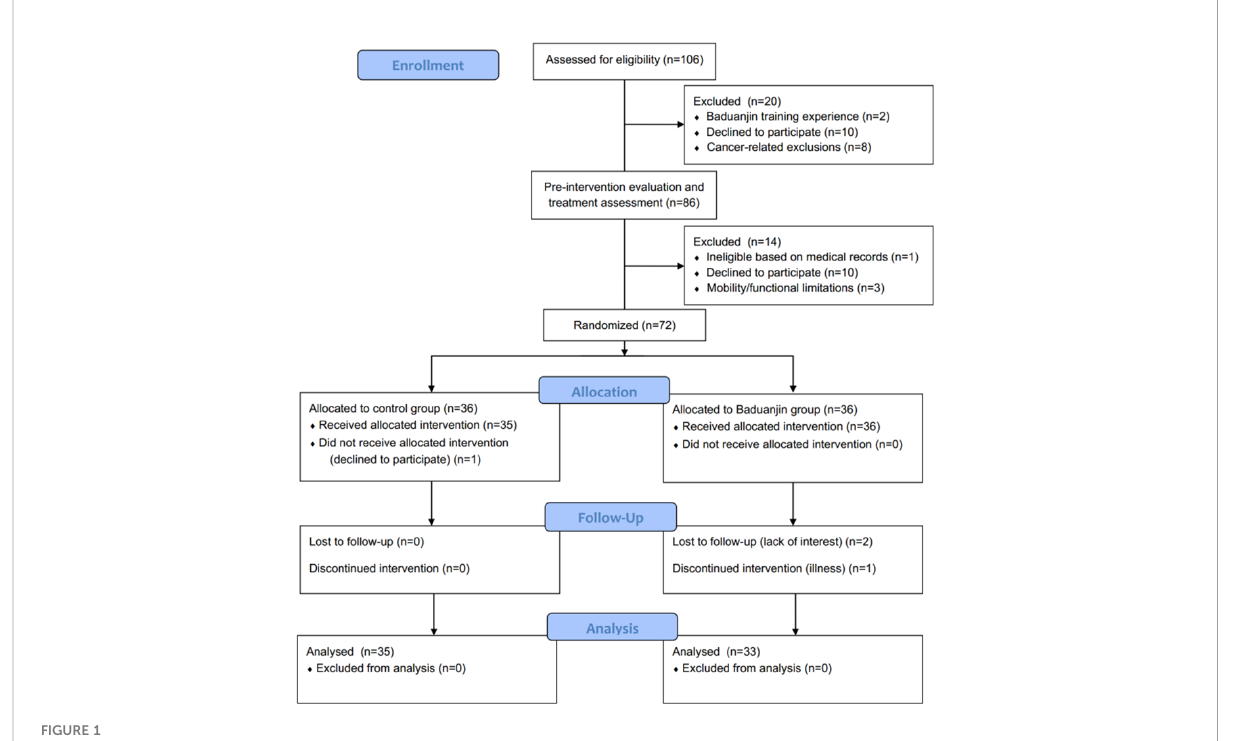
FIGURE 1 Flow Diagram Depicting the Study